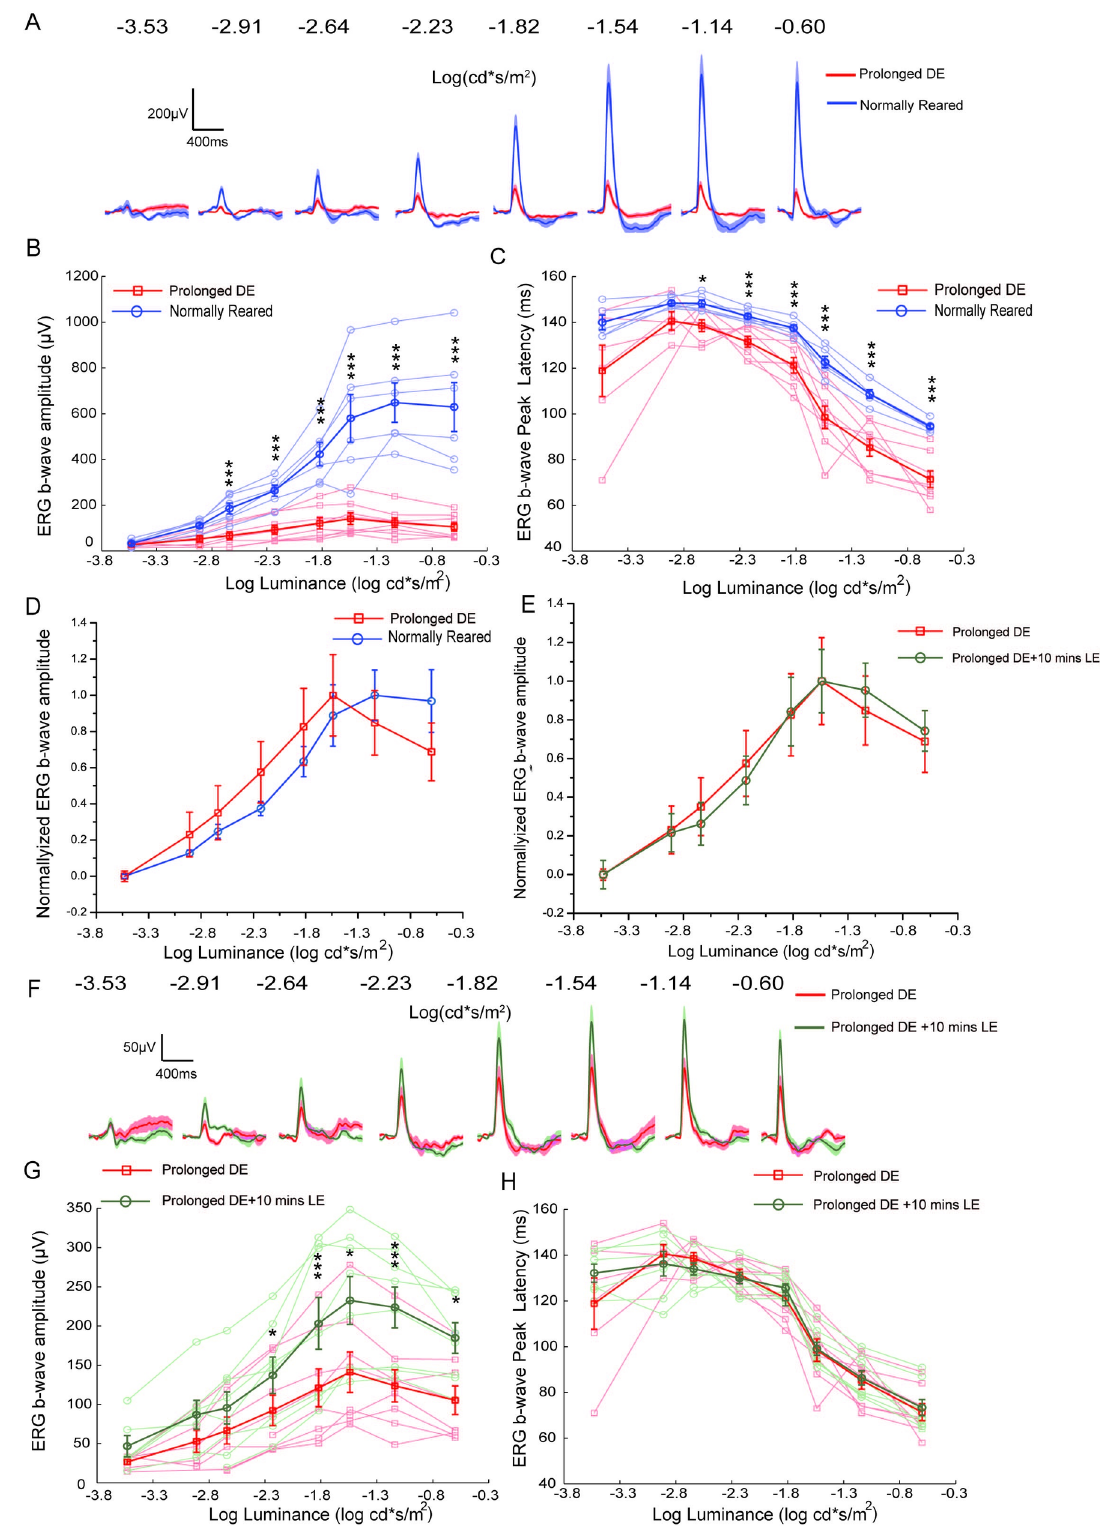
Fig 6. The shift of light intensity-ERG response curves after light manipulations. (A) Mean ERG b-waves of the 24 hours dark exposed (DE) rats (n = 8, red) and normally reared rats (n = 6, blue), SEM is shown as the shadow. (B) Light